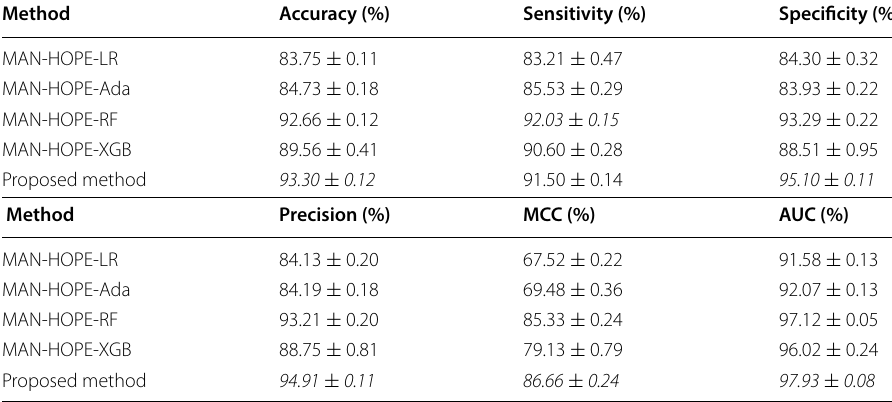
Best metrics are highlighted in italic; we split table in two for legibility